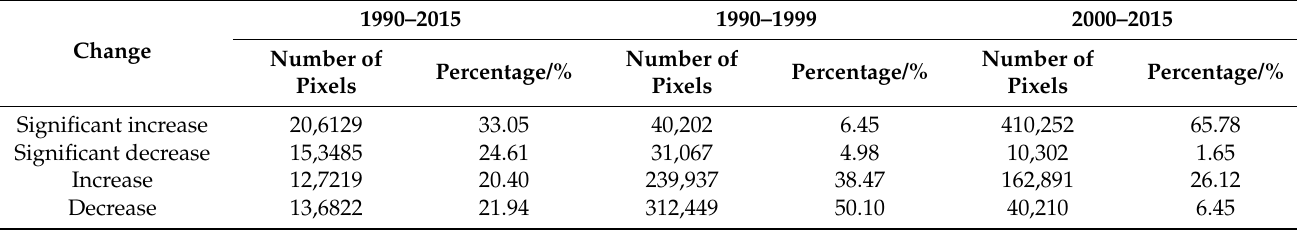
Table 6. Number and percentage of NDVI change types of pixels in the growing season of the Loess Plateau in each time